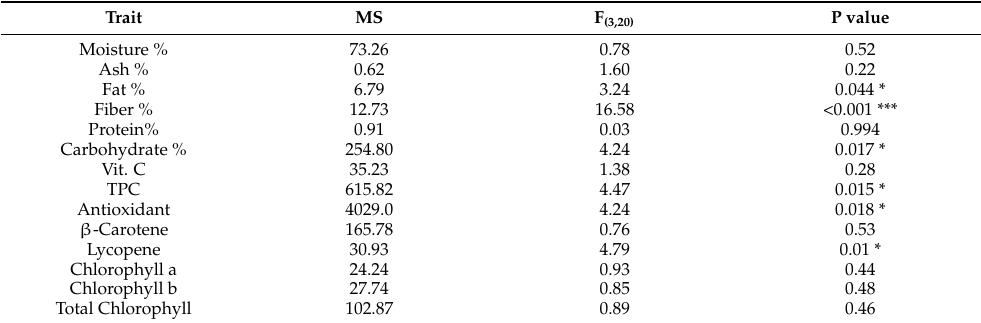
Table 3. Analysis of variance of bio-stimulants for the nutritional value and biochemical traits of okra pods stored for 12 days.